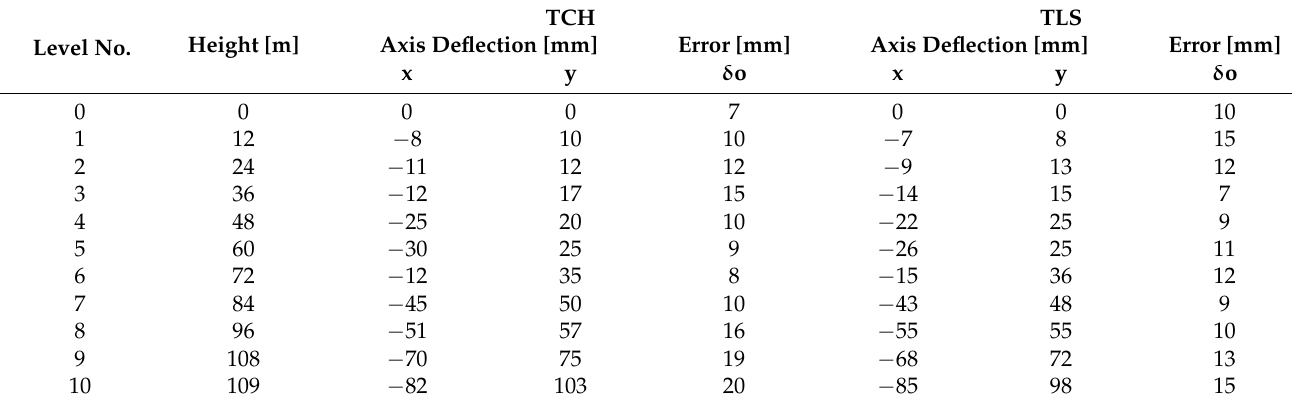
Table 4. Horizontal deflections of the industrial smokestack.